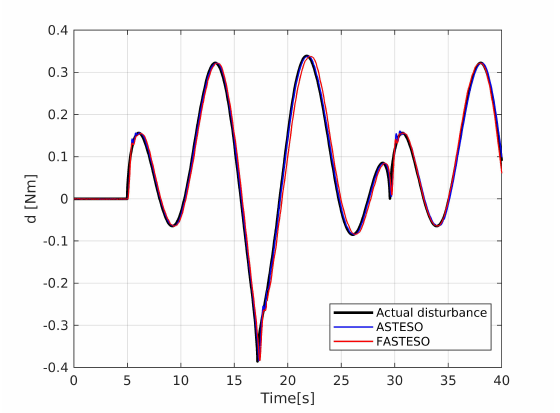
Figure 6. Estimation results from ASTESO and fuzzy adaptive saturation super-twisting extended state observer (FASTESO) with scalar a = 10.